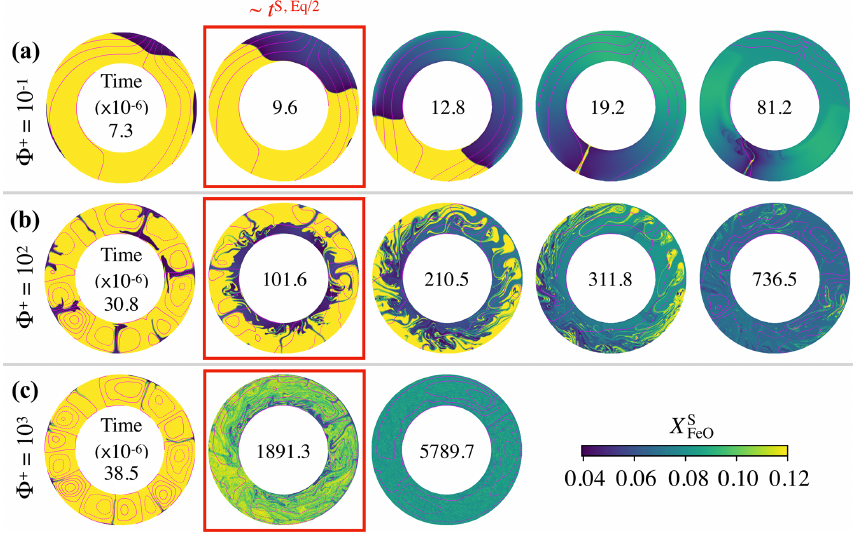
, is reached. In these simulations, FeO